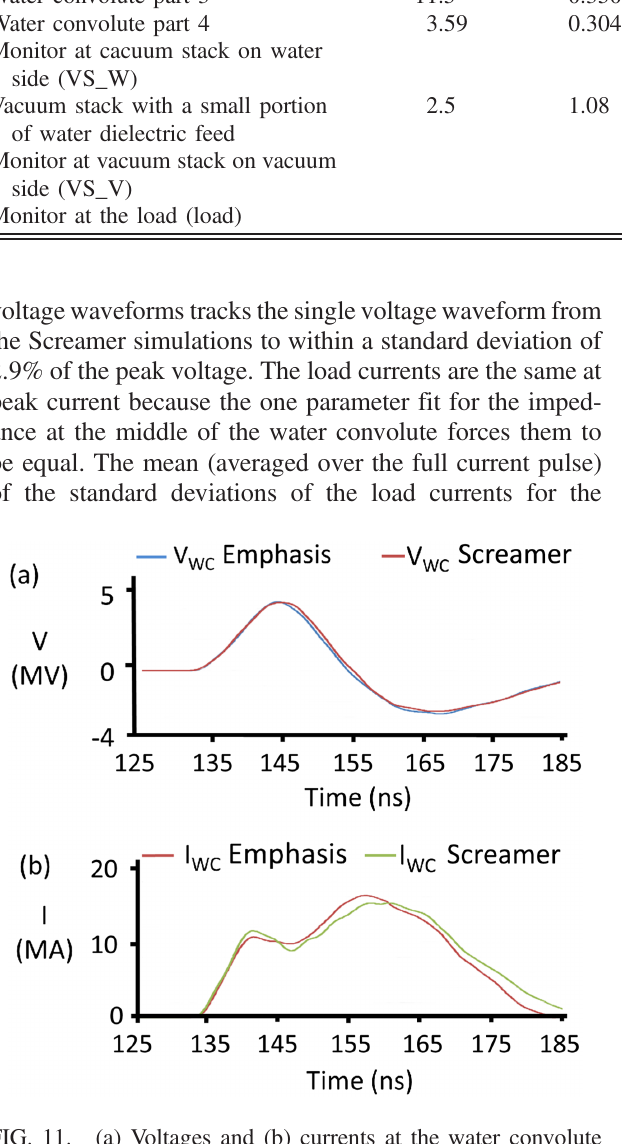
FIG. 11. (a) Voltages and (b) currents at the water convolute (WC), the transition from the output transmission lines to the vacuum insulator input, are shown from Emphasis and Screamer simulations of